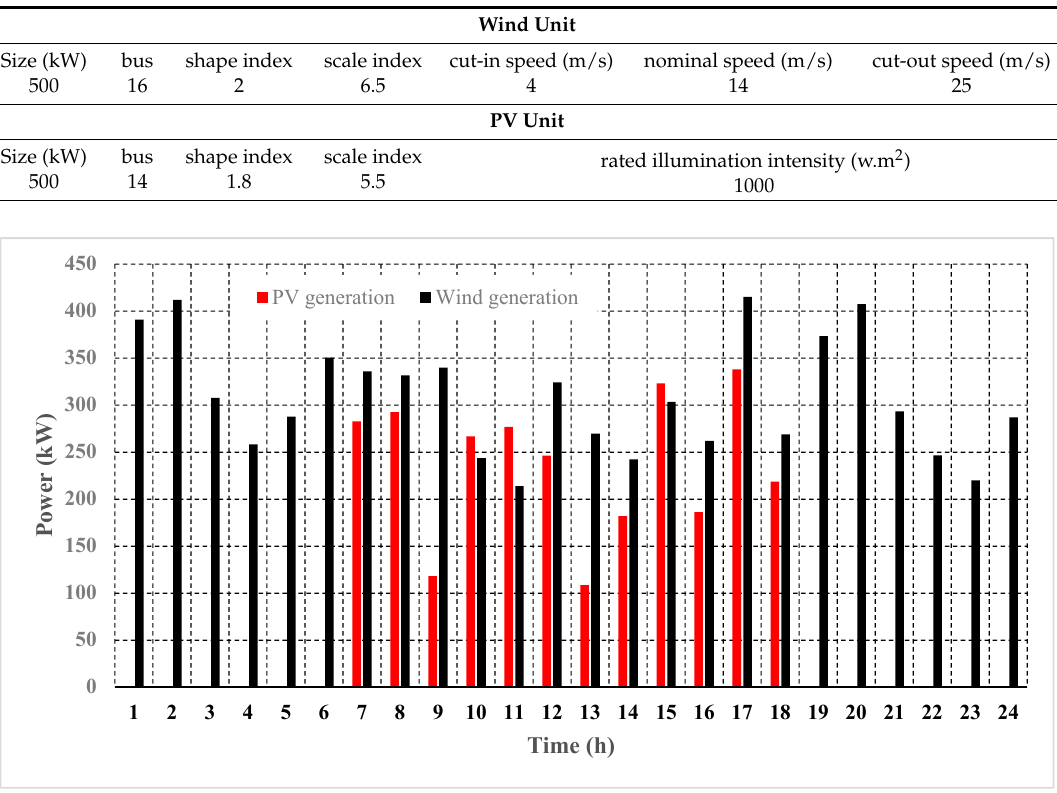
Figure 4. PV and wind power generation. Figure 4 . PV and wind power generation.